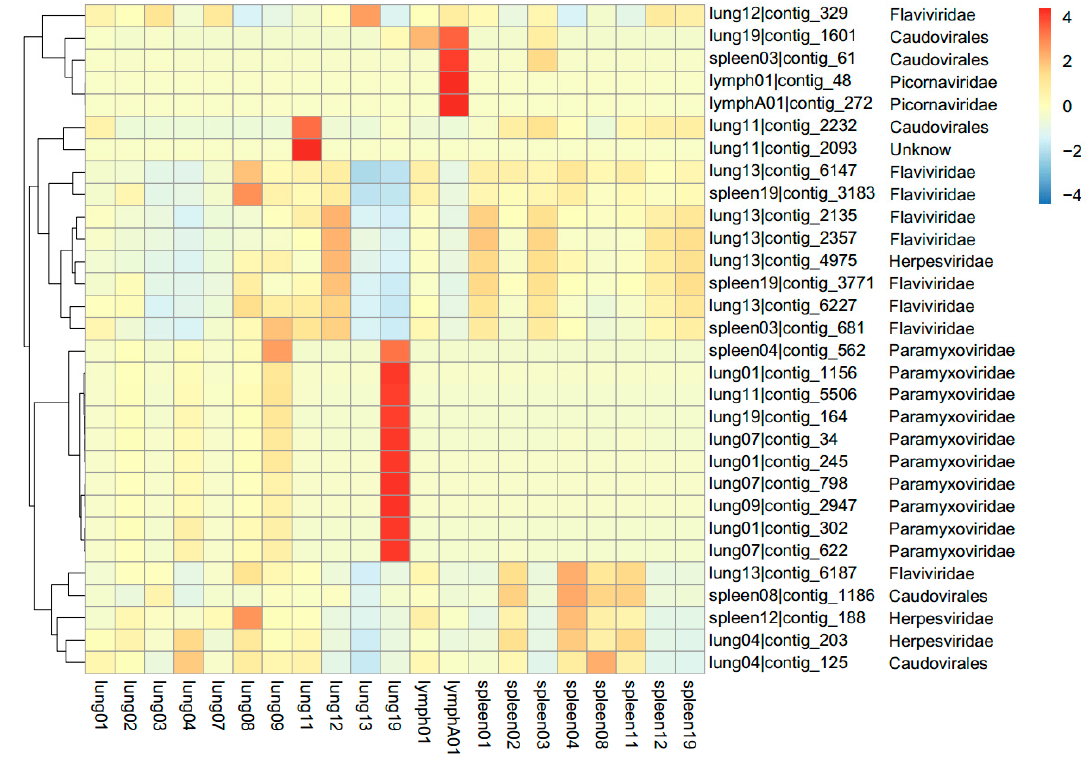
Figure 2. Heatmap of contigs with the top 30 abundance of sequence reads in each sample. The pangolin samples are listed below the heatmap. Information of contigs and the virus families they belong to is provided in the right text column. The boxes colored from blue to red represent the abundance of virus reads aligned to each contig.